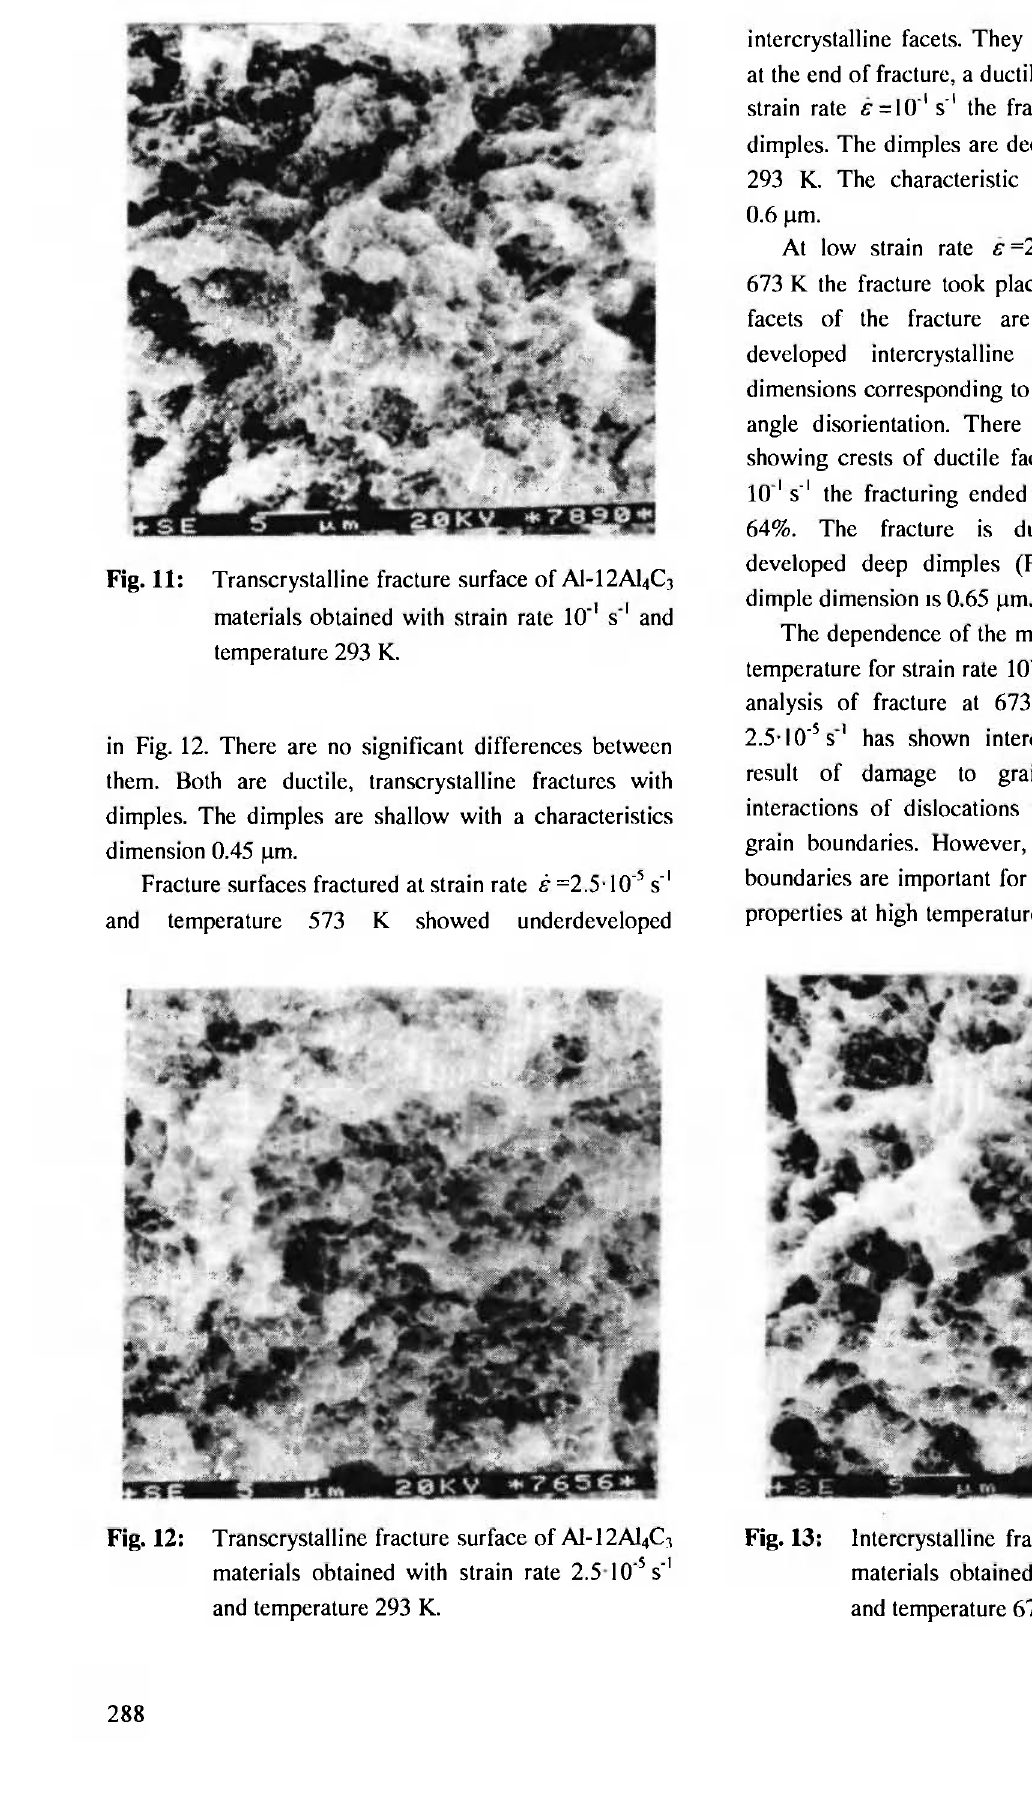
Fig. 12: Transcrystalline fracture surface of AI-I2AI4Q materials obtained with strain rate 2.5l0" 5 s"' and temperature 293 K.